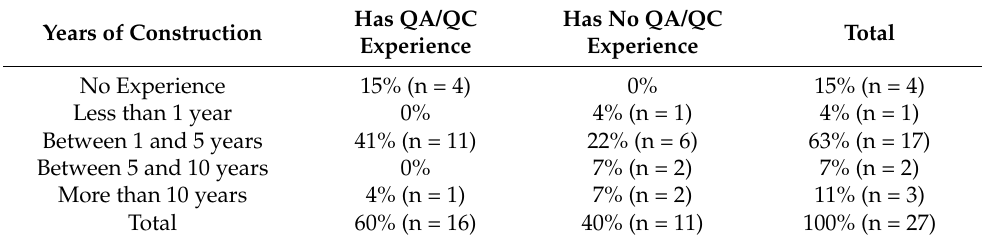
Table 2. Cross-tabulation of participants’ years of construction experience and quality control experience.